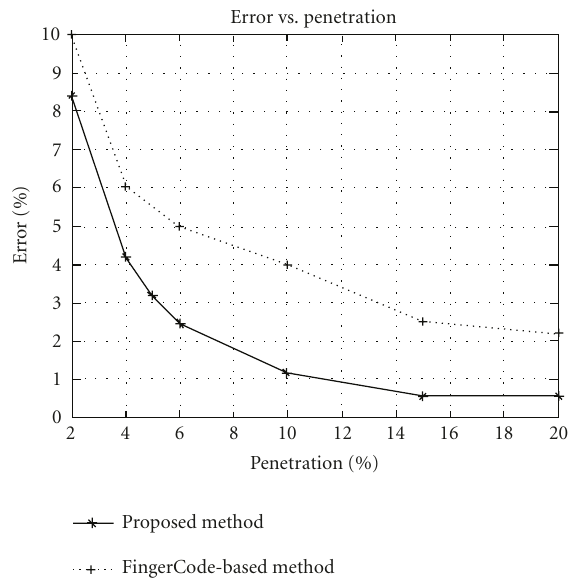
Error vs. penetration